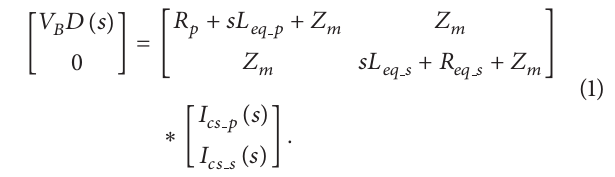
Figure 5. Equation (1) is the space state model of the